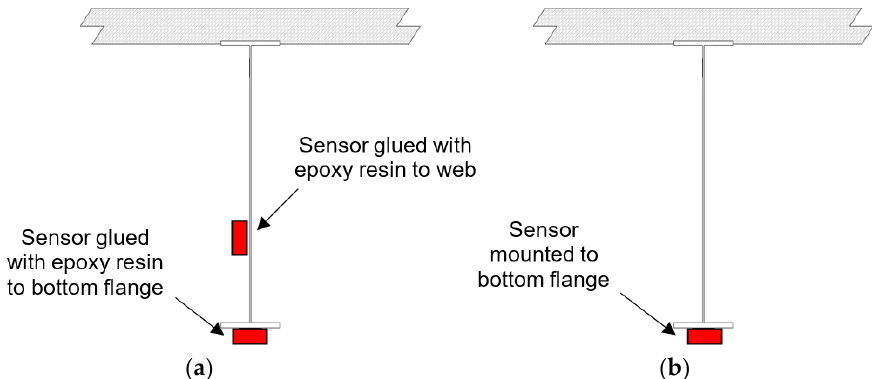
Figure 2. Fiber optic sensor configurations: ( a ) web-and-flange array; ( b ) flange-only array.